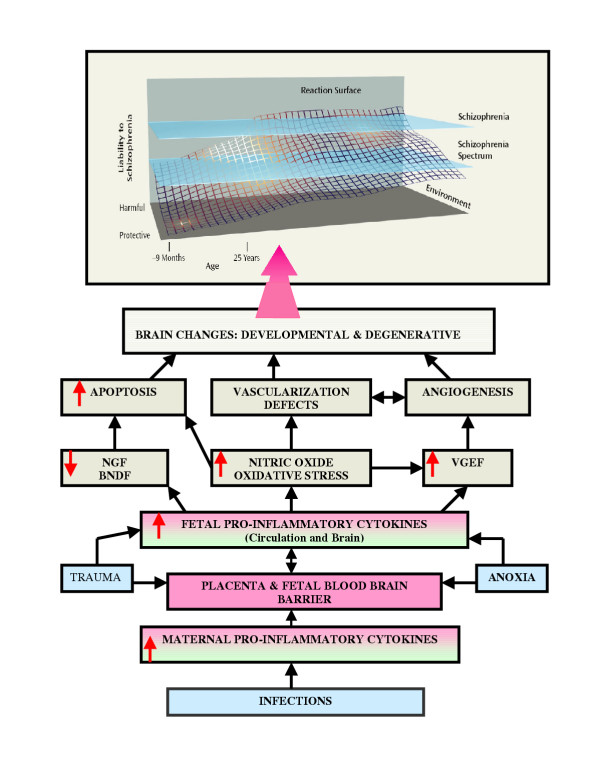
Schematic illustration of how inflammatory processes, from conception onward, may lead to CNS damage or dysfunction that dynamically alters the epigenetic landscape (reaction surface) thus affecting the liability for developing schizophrenia. Blue planes intersecting the reaction surface indicate levels of liability above which symptoms become manifest. Measurable factors in the middle of the figure are good candidates for endophenotypes. Adapted from [261,262].